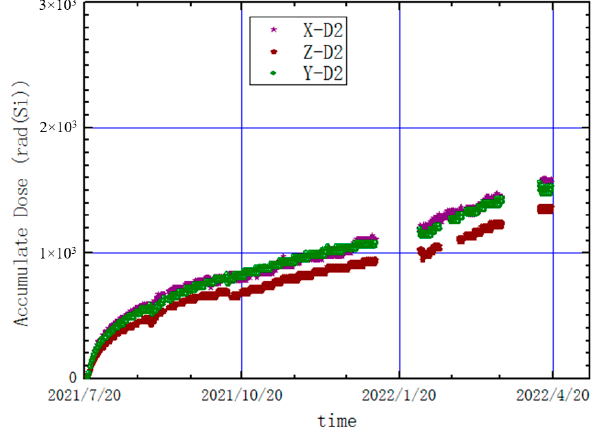
Figure 9. Cumulative dose results of the three dose detectors at monitoring point D2.